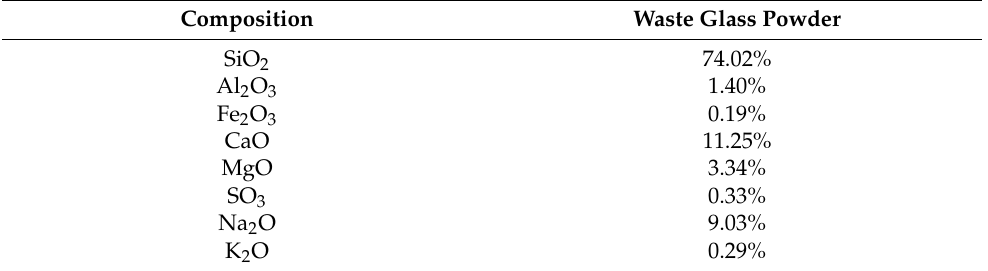
Table 1. Chemical ingredients of WGP.